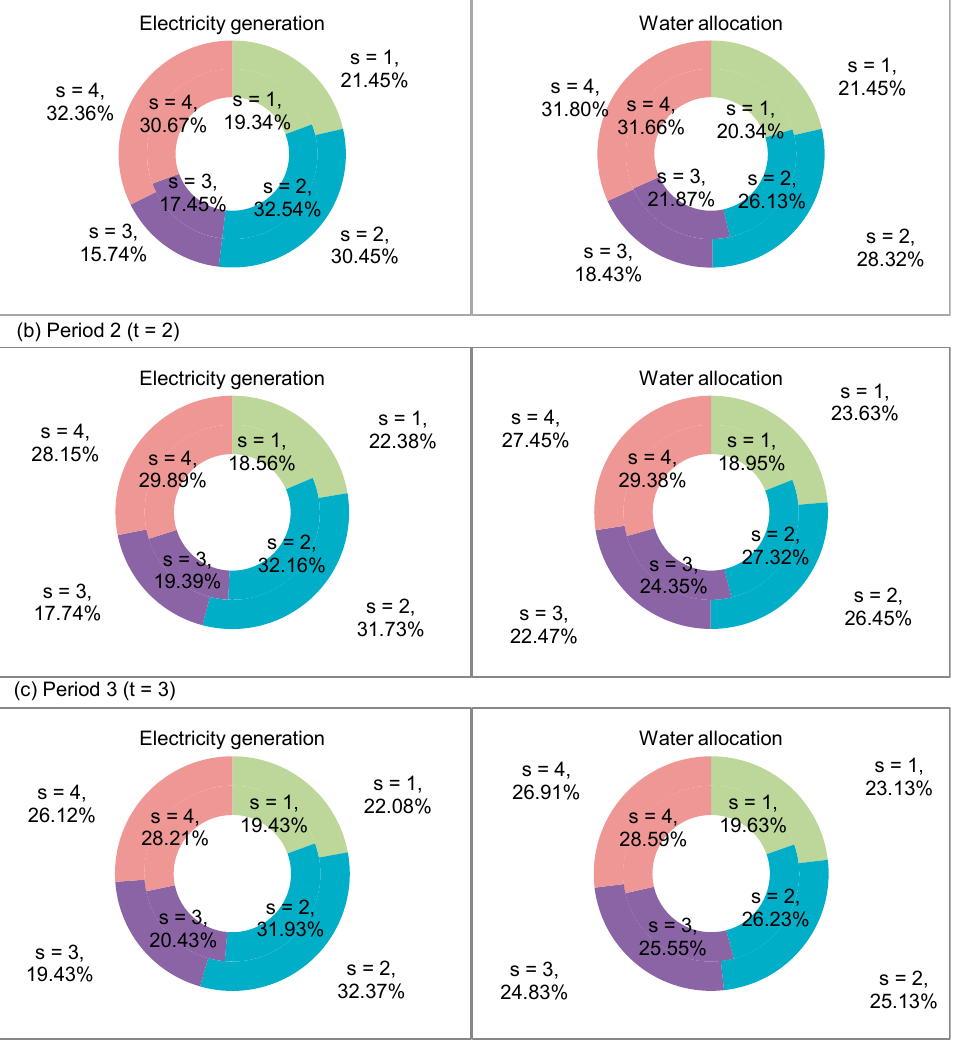
Figure 7. Proportion of electricity generation and water supply in each season: ( a ) period 1 ( t = 1); ( b ) period 2 ( t = 2); ( c ) period 3 ( t = 3).